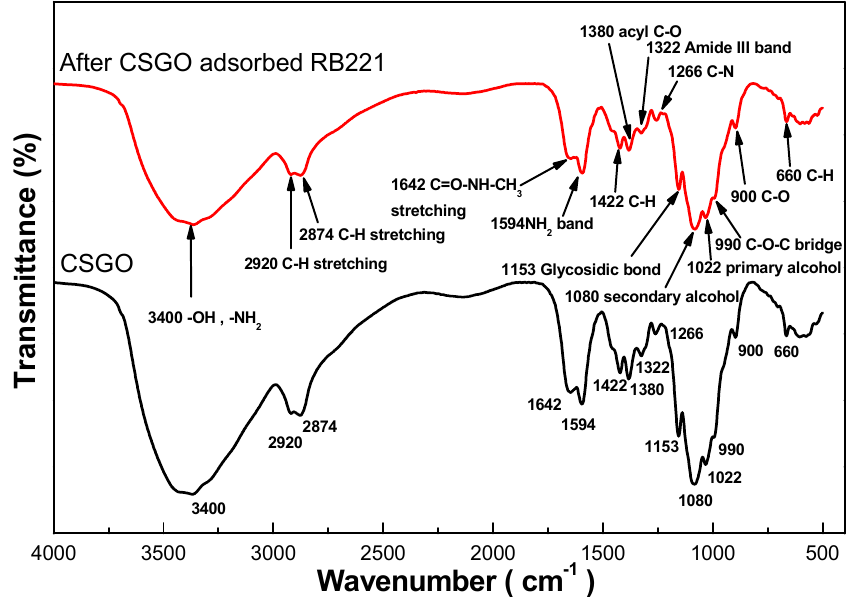
Figure 5. Changes in the IR spectra of CSGO after the adsorption of RB221.